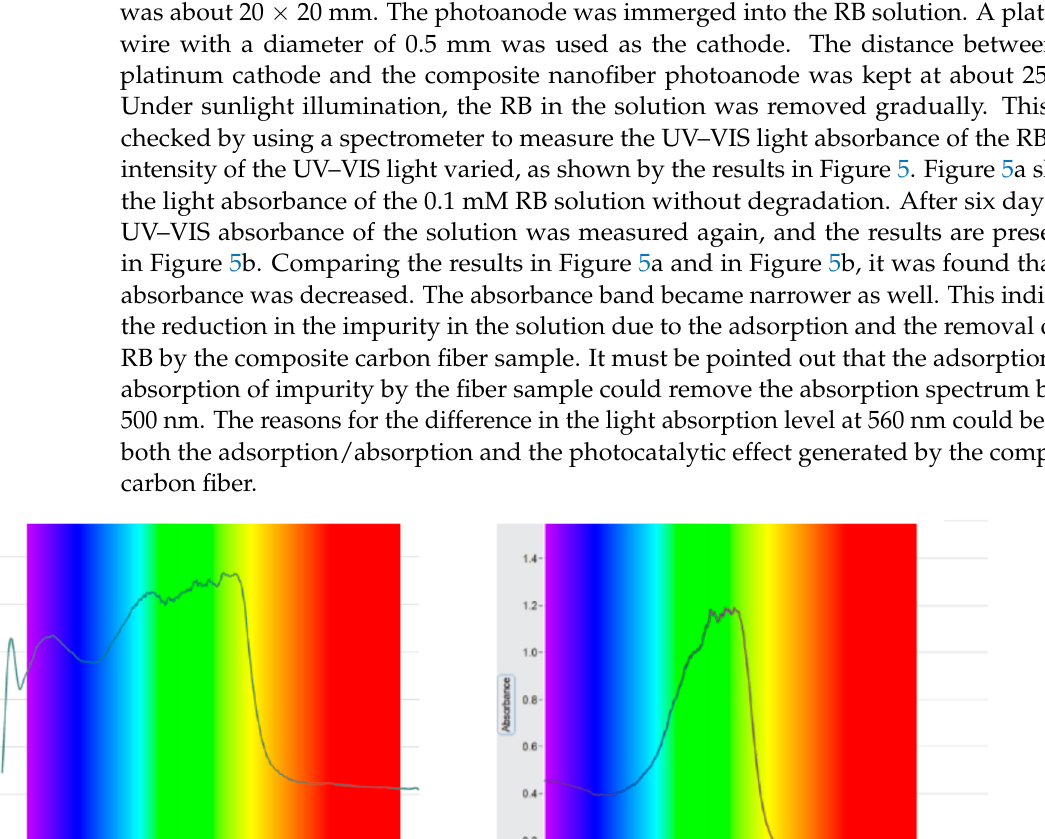
Figure 4. Open-circuit voltages of the cobalt(II) titanate particle-containing composite carbon fiber ( a ) and the titanium dioxide particle-containing composite carbon fiber ( b ).